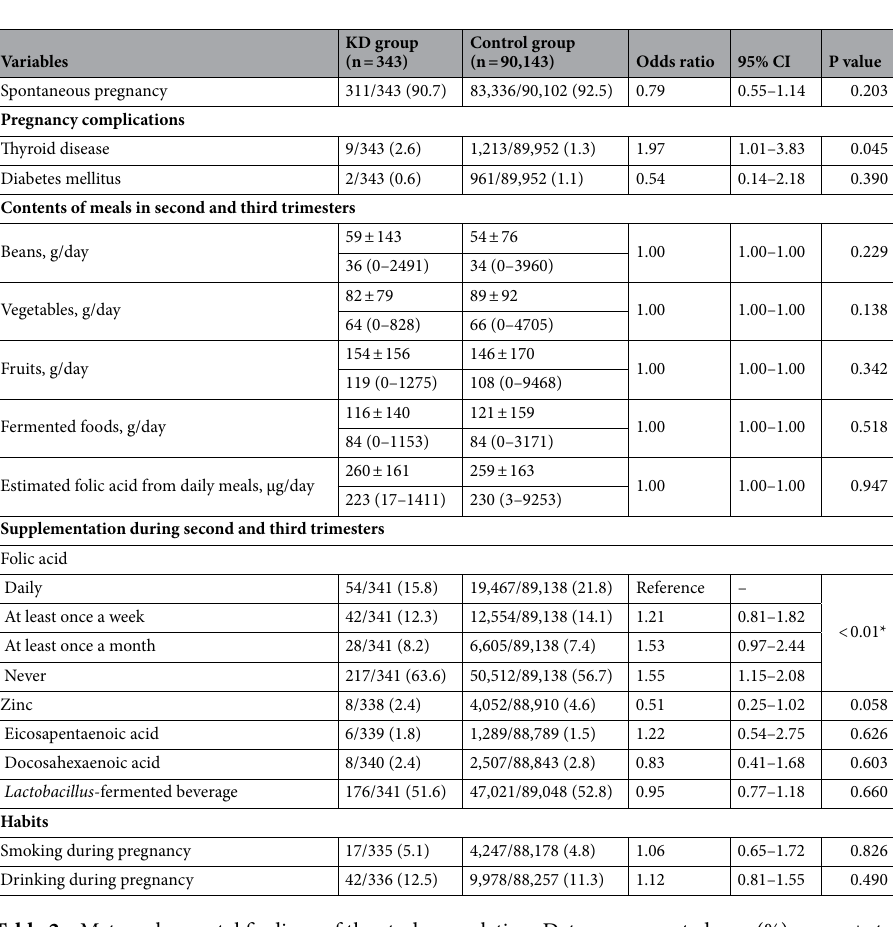
Table 2. Maternal prenatal findings of the study population. Data are presented as n (%), mean ± standard deviation, or median (range). KD Kawasaki disease, 95% CI 95% confidence interval. *P-value for trend.